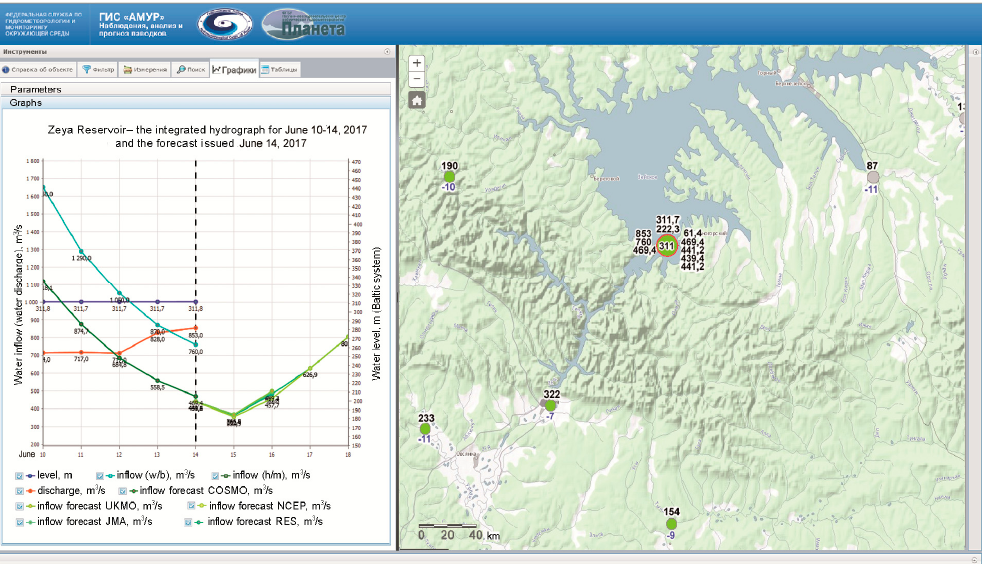
Figure 6. Format of dissemination of the inflow forecast to the Zeya reservoir to main end-users.